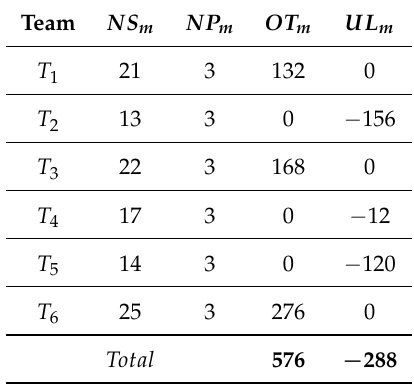
Table 5. Analysis of the manual physician schedule for September.